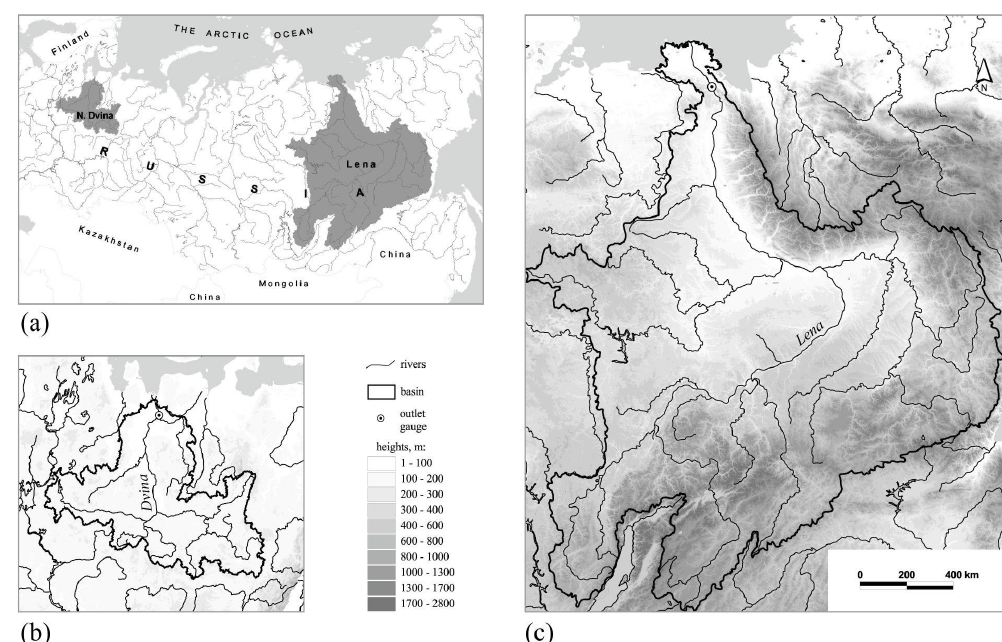
Figure 1. Case study basins: location (a) , Northern Dvina River basin (b) , Lena River basin (c)